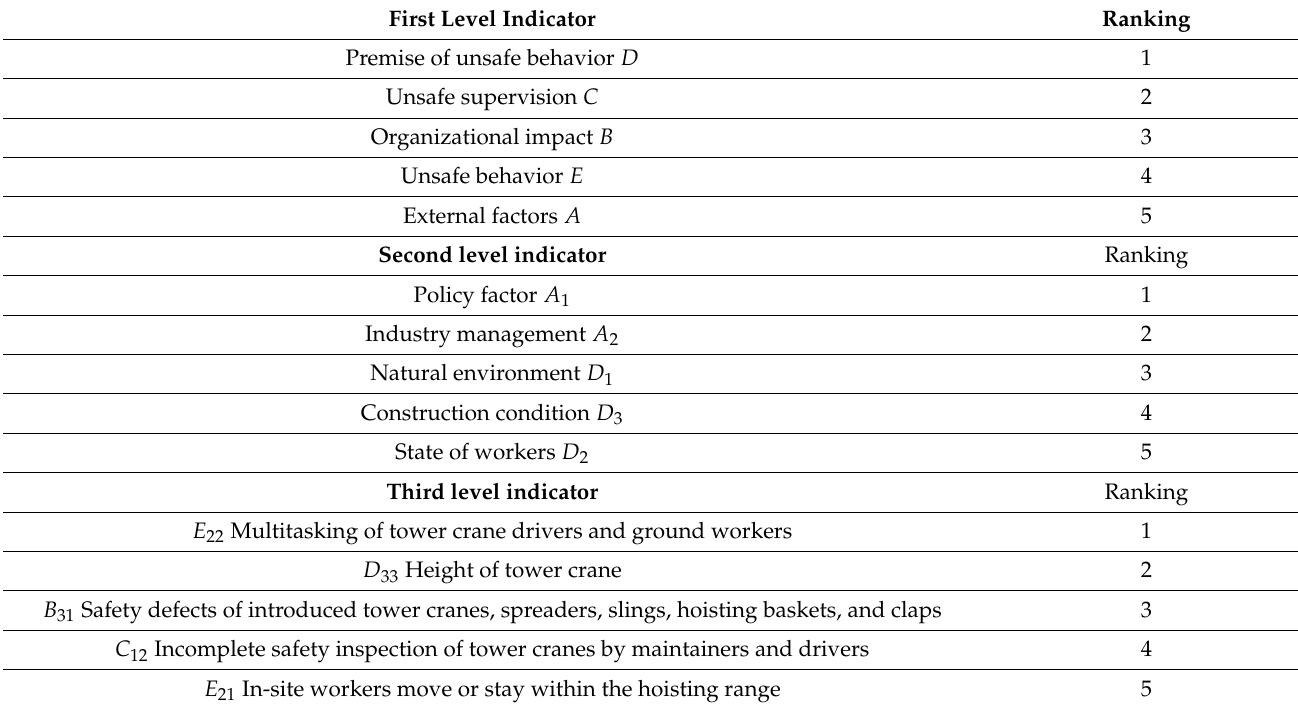
Table 13. Ranking of the sensitivity of each indicator at the three